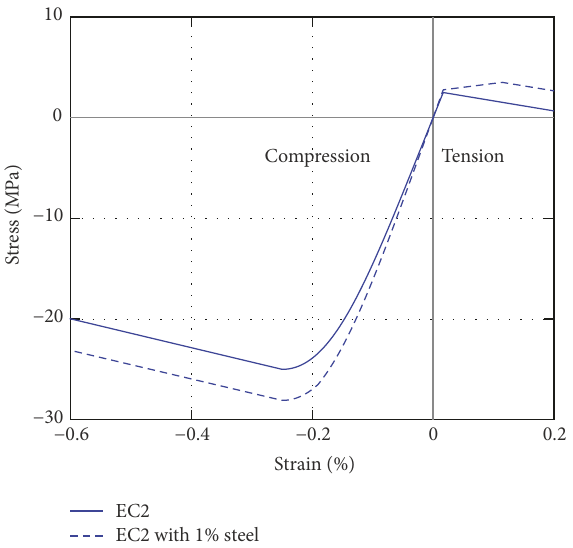
Figure 8: Comparison of displacements between finite element models and test.